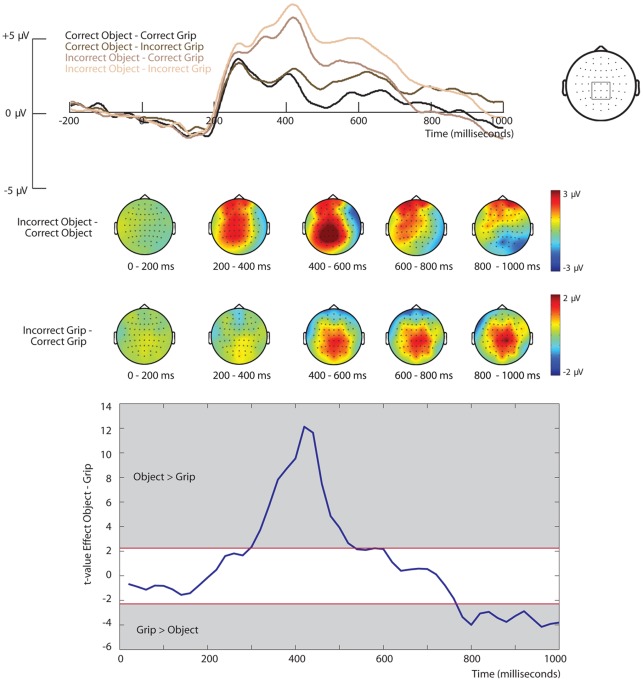
ERPs relative to the onset of the 2nd picture.ERPs relative to the onset of the 2nd picture for a selection of central electrodes. Topographical plots represent the difference between Incorrect and Correct Objects (upper panel) and the difference between Incorrect and Correct Grips (middle panel. The lower panel reflects the t-values for the comparison between the Object Effect (Incorrect – Correct Object) and the Grip Effect (Incorrect – Correct Grip). The critical t-values are marked in red and a positive t-value reflects a stronger effect of Object than of Grip and a negative t-value reflects a stronger effect of Grip than of Object.